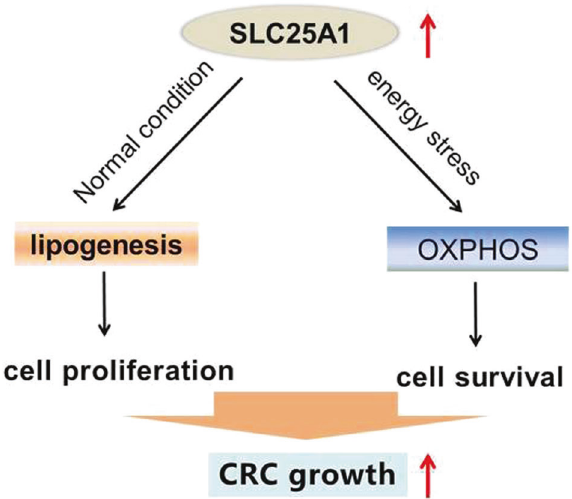
Fig. 7 Schematic depicting the role of SLC25A1 in the metabolism reprogramming and progression of